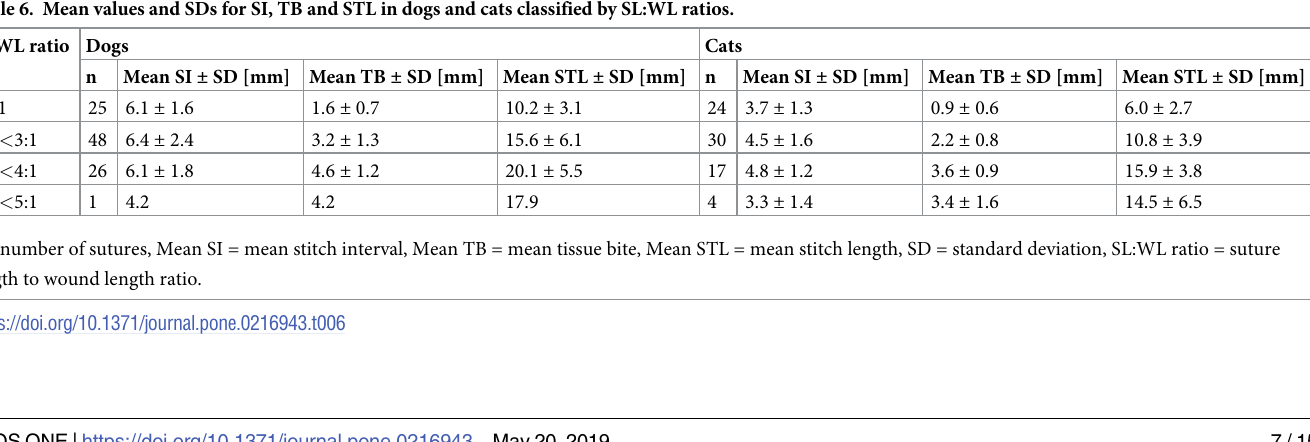
Mean stitch interval, mean tissue bite and mean stitch length The SL:WL ratios are presented in Table 6 with the mean SI ± SD, mean TB ± SD and mean STL ± SD. Most of the SL:WL ratios were less than 4:1. In these patients, the increase in the SL: WL ratio was due to an increase in the mean TB, mean STL and mean SI. It must be noted, however, that the mean SI remained nearly stable in dogs. The mean SI ± SD and TB ± SD cat- egorized as SL:WL ratios < 2:1, 2:1- < 3:1, 3:1- < 4:1 and 4:1- < 5:1 are shown in Fig 2 for dogs and in Fig 3 for cats. Since not enough SL:WL ratios above 4:1 were obtained, the parameters that led to this value could not be objectively evaluated. The mean stitch interval (SI) ± standard deviation (SD) [mm] is depicted in white, and the mean tissue bite (TB) ± SD [mm] is shown in black. Note that for a suture length to wound length (SL:WL) ratio of 4:1- < 5:1, there was only one patient. The mean stitch interval (SI) ± standard deviation (SD) [mm] is depicted in white, and the mean tissue bite (TB) ± SD [mm] is shown in black. Note that for a suture length to wound length (SL:WL) ratio of 4:1- < 5:1, there were only four patients. Comparison of the mean tissue bite and mean stitch interval with textbook recommen- dations. In dogs, the overall mean TB was 3.2 ± 1.6 mm, and the mean SI was 6.2 ± 2.1 mm. The mean TB corresponded with the range as defined in Rosin‘s statements [21] but differed from the suggestions of Tobias [24], Fossum [22], Smeak [23] and Bellenger [16]. The mean SI Table 6. Mean values and SDs for SI, TB and STL in dogs and cats classified by SL:WL ratios. SL:WL ratio Dogs Cats n